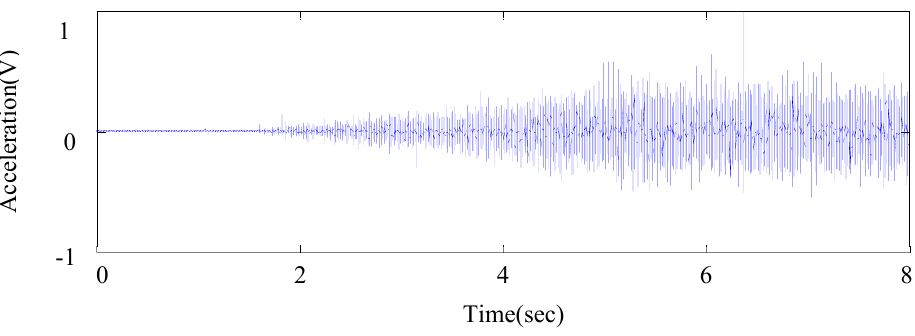
Figure 7. The time domain waveform of the collected original signal.